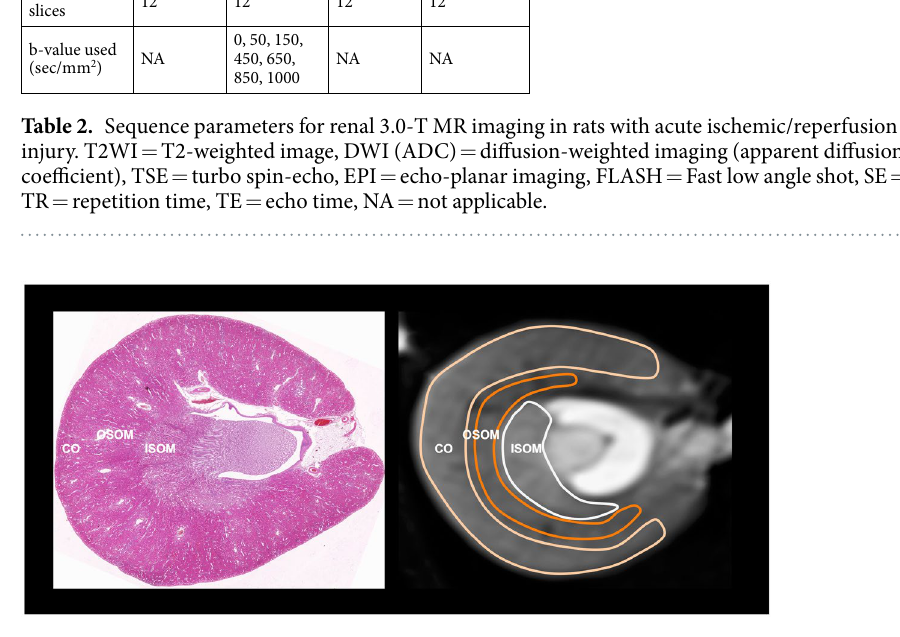
Figure 6. Axial histological section at kidney (left) and corresponding T2-weighted image (right) at the central part of the kidney illustrate the placement of regions of interest along the boundaries of the anatomic zones of the renal cortex (CO) outer strip of the outer medulla (OSOM) and inner stripe of the outer medulla (ISOM). The ROI outlines were copied and pasted on the ADC, T1, and T2 maps for the measurements of ADC values, and T1and T2 relaxation